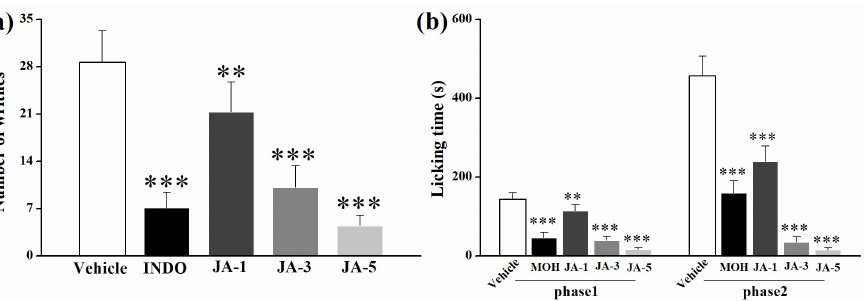
Figure 4. Antinociceptive effects of jegosaponin A (JA) in antinociceptive tests. JA at doses of 1, 3 and 5 mg/kg in the writhing test ( a ) and the formalin test ( b ). Vehicle: blank control, INDO: indomethacin, MOH: morphine hydrochloride. Data are displayed as mean ± SD. ** p < 0.01, *** p < 0.001 vs. vehicle group.